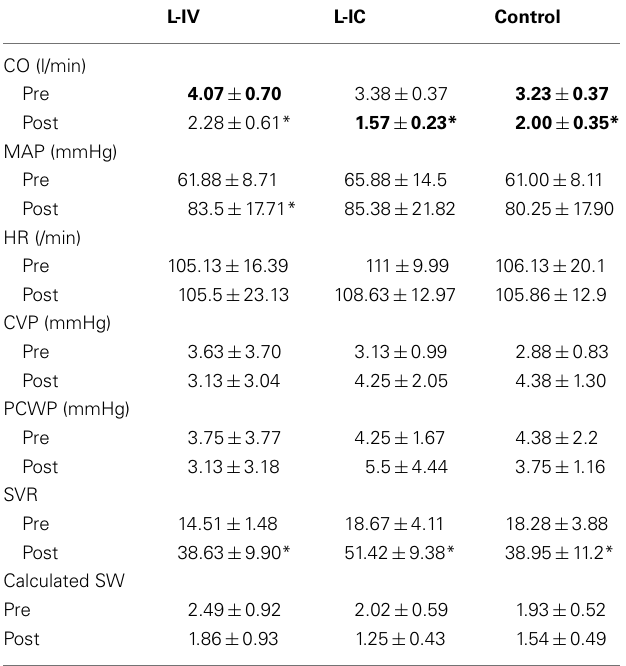
Table 2 | Results of the hemodynamic measurements at the beginning (pre) and at the end of the experiment (post).